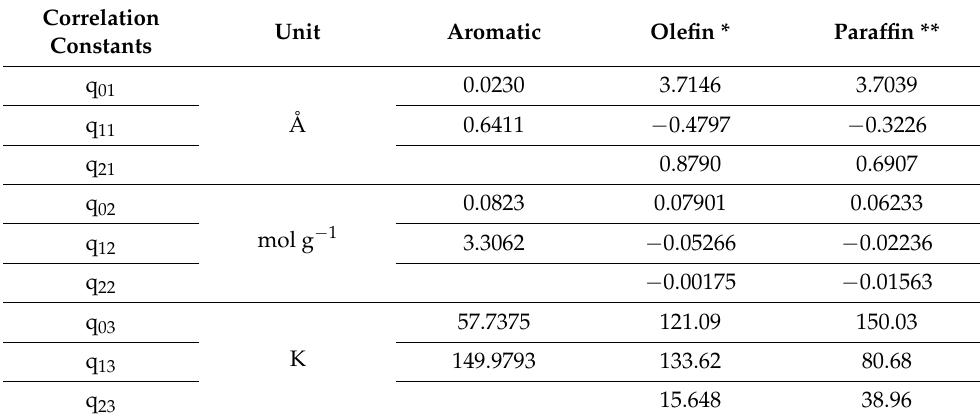
Table 2. PC-SAFT correlation constants used for aromatics, paraffins, and olefins.